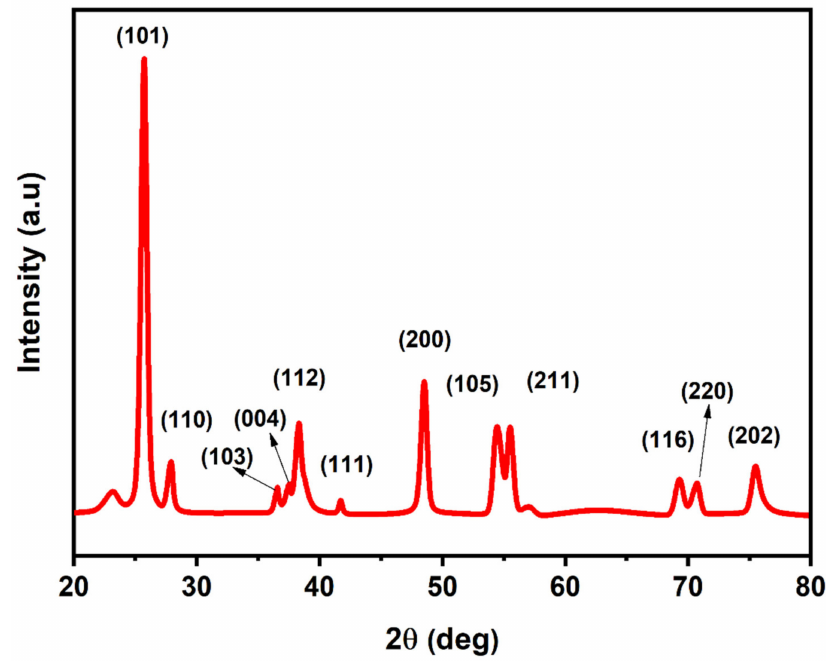
Figure 2. X-ray diffraction pattern of TiO 2